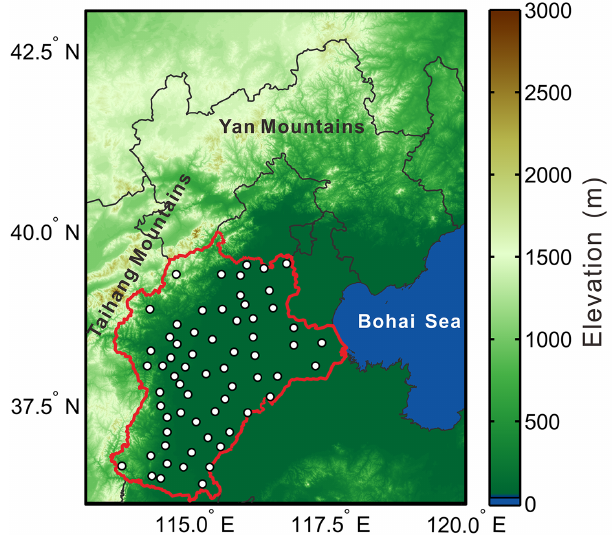
Figure 1. The location of the measurement sites (circle), the area of study (red line) and the regional topography by Danielson and Gesch (2011)